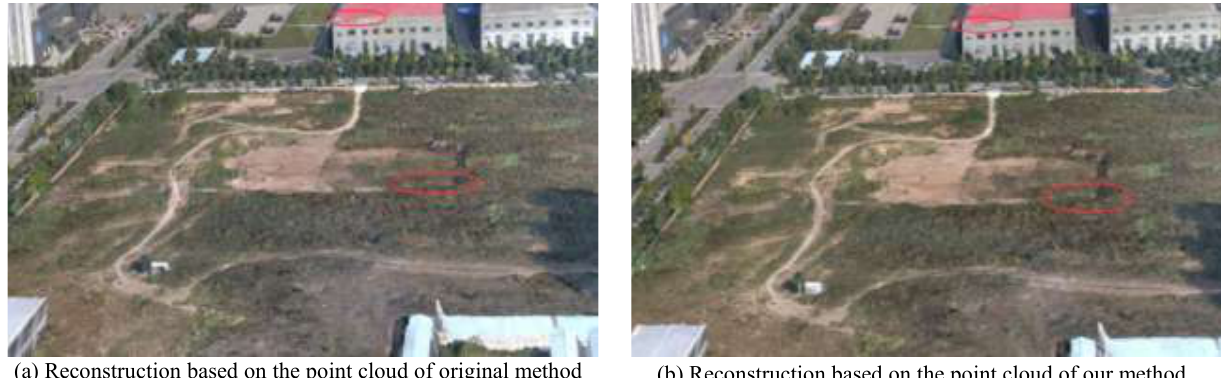
Figure4. Comparison of point clouds generated by different methods